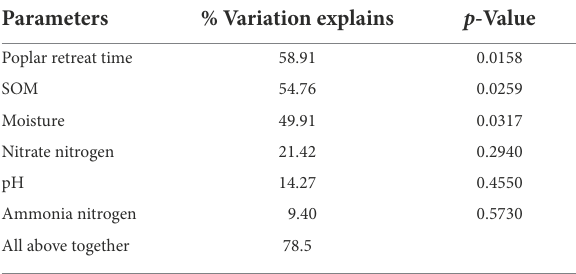
TABLE 3 Monte Carlo experiment to test the influence of poplar retreat time and soil properties on the results.